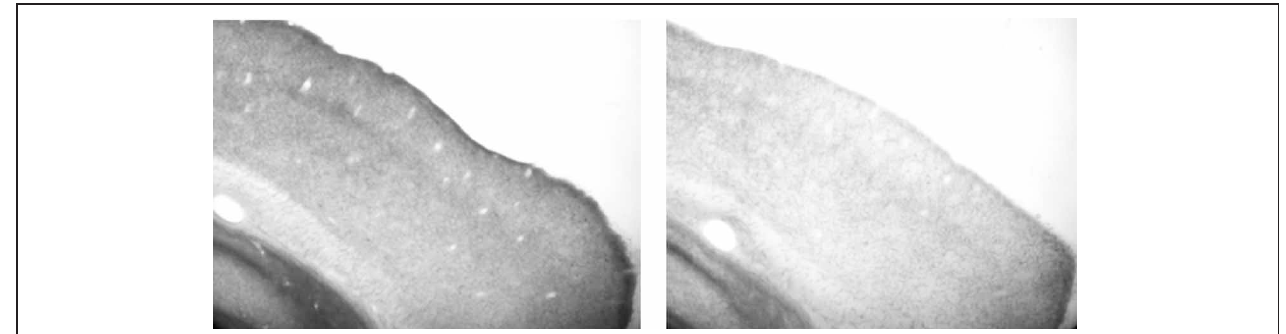
FIGURE 2 | Representative sagittal sections stained for acetylcholinesterase. Left panel: visual cortex of ACSF infused rat. Right panel: visual cortex of 192 IgG-saporin infused rat,